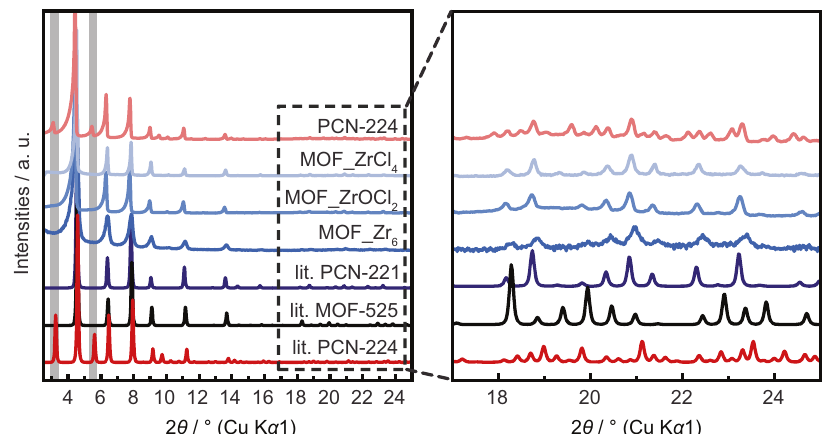
Fig. 2 Powder X-ray diffraction (PXRD) patterns for samples and models. Comparison of measured PXRD patterns (Cu K α 1 ) of MOF_ZrCl 4 , MOF_ZrOCl 2 , MOF_Zr 6 , and experimental PCN-224 and simulated PXRD patterns (lit.) of PCN-221, MOF-525, and PCN-224 17,21,22 . The gray bars highlight the superstructure re fl ections of PCN-224 at 3.2 and 5.5° 2 θ